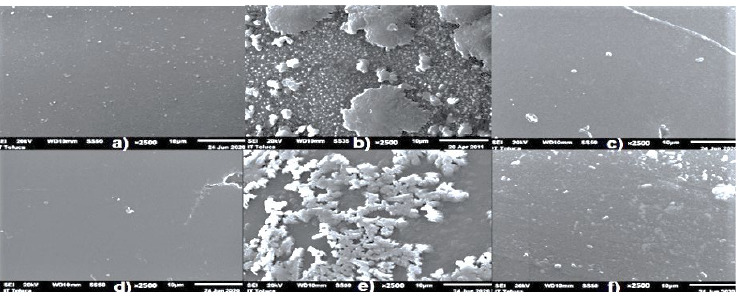
Figure 5. Micrographs at ×2500 of the sample surface resins. Cationic: ( a ) initial, ( b ) saturated, ( c ) regenerated. Anionic: ( d ) initial, ( e ) saturated, ( f ) regenerated.